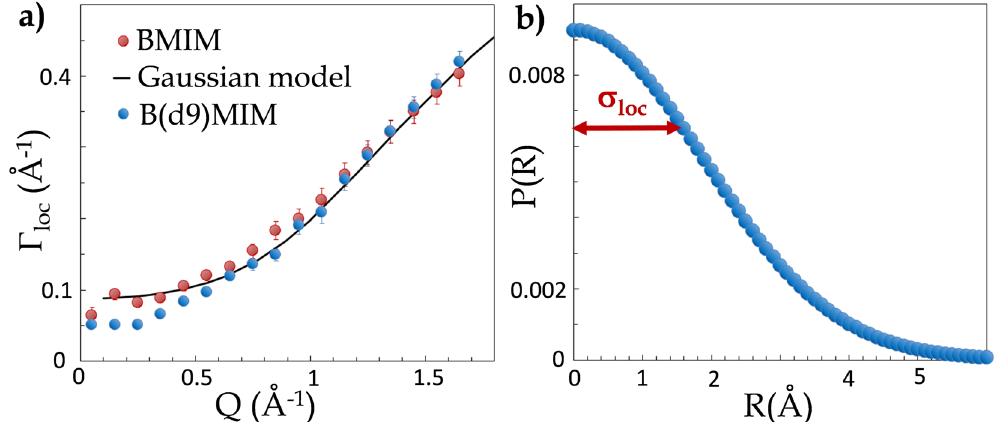
Figure 3. ( a ) HWHM, Γ loc , related to the diffusion of BMIM-TFSI and B(d9)MIM-TFSI within the transient nanometric IL aggregates (Eq. S6). The full line is the fit of the experimental points with the Gaussian model (see section 3 of the SI text). The local diffusion coefficient of the cation within the BMIM-TFSI nanodomains, D loc = 4.8 ± 0.3 10 − 5 cm 2 /s. (b) Characteristic size of an aggregate: 6 × σ loc = 11.4 ± 1.2 Å. (EISF eq.